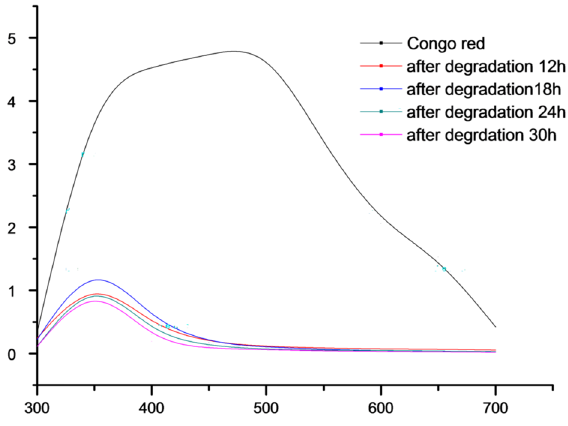
Fig. 6 UV–visible absorption spectrum of Congo red before and after CR decolorization